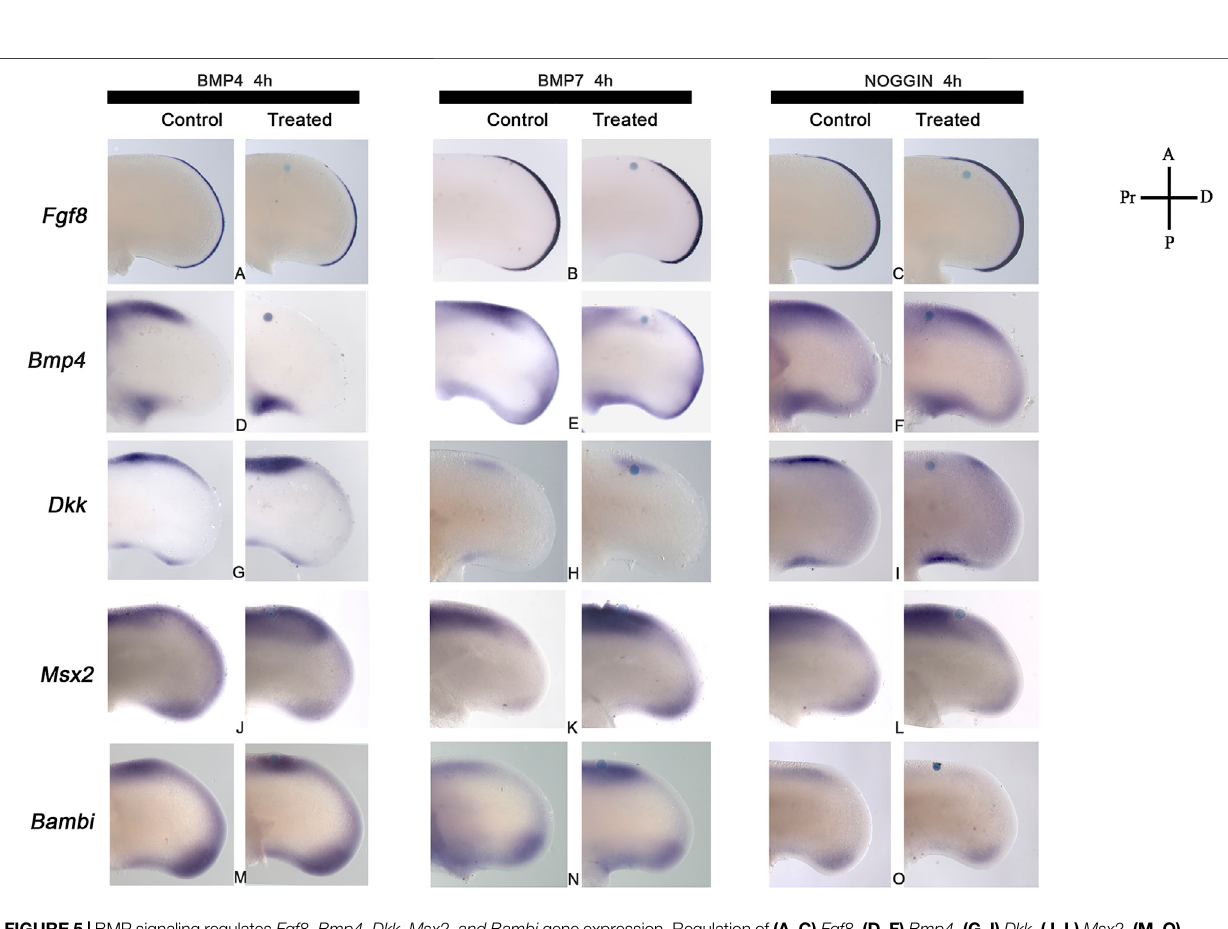
Frontiers in Cell and Developmental Biology |